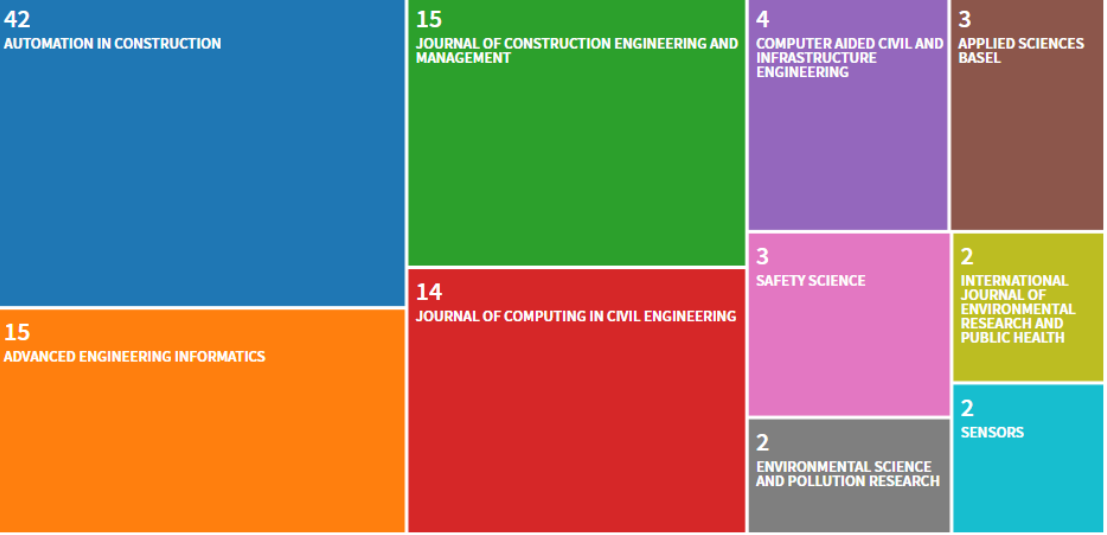
Figure 6 . Source statistics of publications. Figure 6. Source statistics of publications.